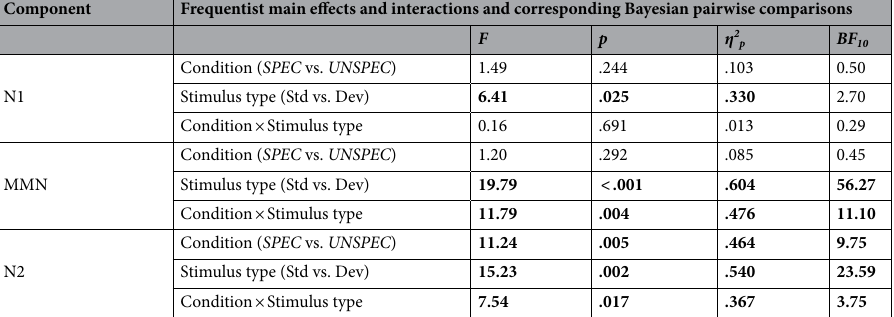
Table 1. Results of Statistical Analyses. For each of the three components of interest, a 2 × 2 frequentist ANOVA with factors Condition ( SPEC vs. UNSPEC ) and Stimulus type (standard vs. deviant) was computed. Corresponding Bayesian pairwise comparisons tested the magnitude (or the lack) of the evidence regarding the frequentist main effects and interactions (for a detailed description, see “Statistical analyses”). Note that these complementary analyses insure optimal correspondence between the Bayesian and frequentist results, while allowing evaluating support provided by the data for the null hypothesis as well. Significant frequentist effects and BF 10 supporting the alternative hypothesis are highlighted in